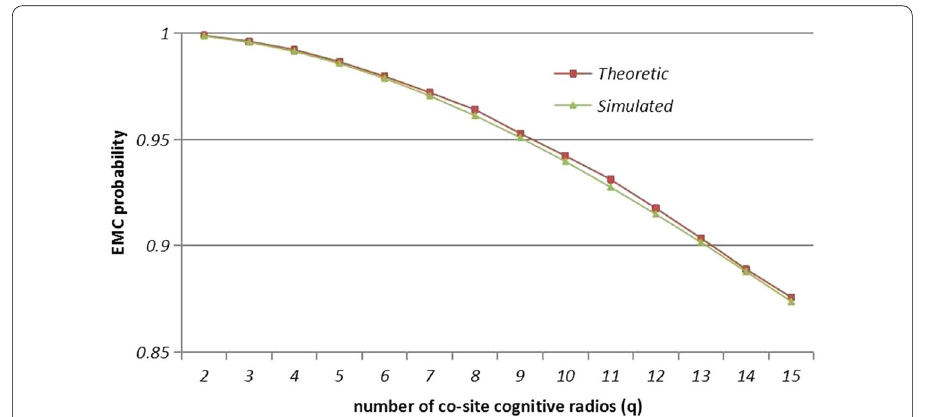
Fig. 5 The probability of no interference between q co-site cognitive